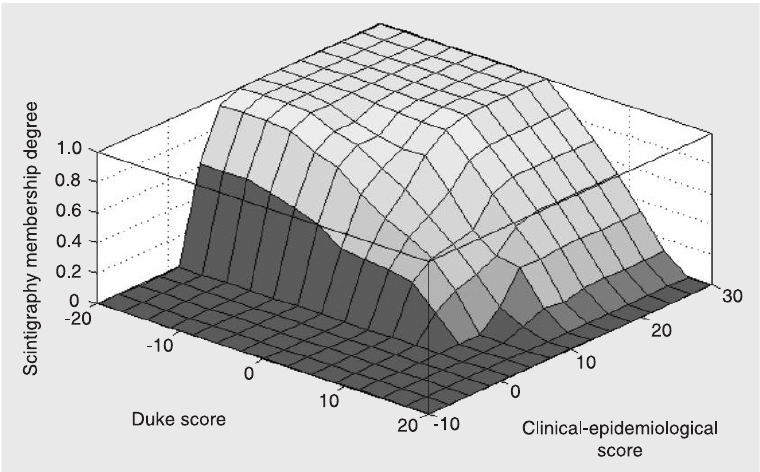
Figure 3. Three-dimensional representation of the final results of the membership degree for the set of patients that should perform scintigraphy, based on fuzzy rules defined by the specialist and the result of Duke and clinical-epidemiological scores.